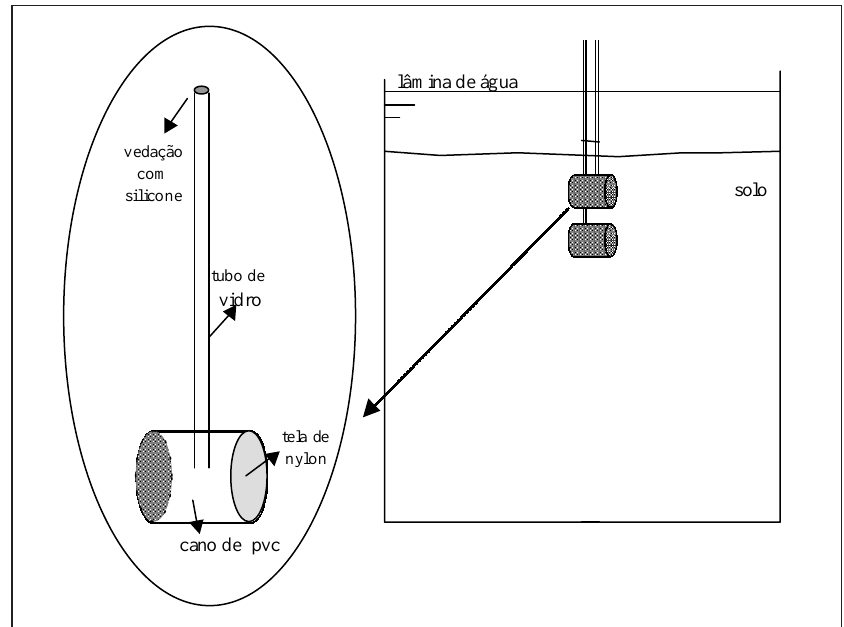
Figura 1. Representação esquemática do sistema de coleta da solução do